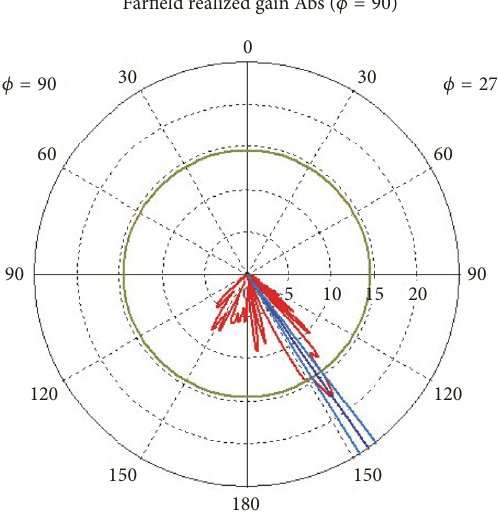
Figure 3: Simulated scanning behaviour of the six-layer lens at 60GHz and 20 mm feed offset.